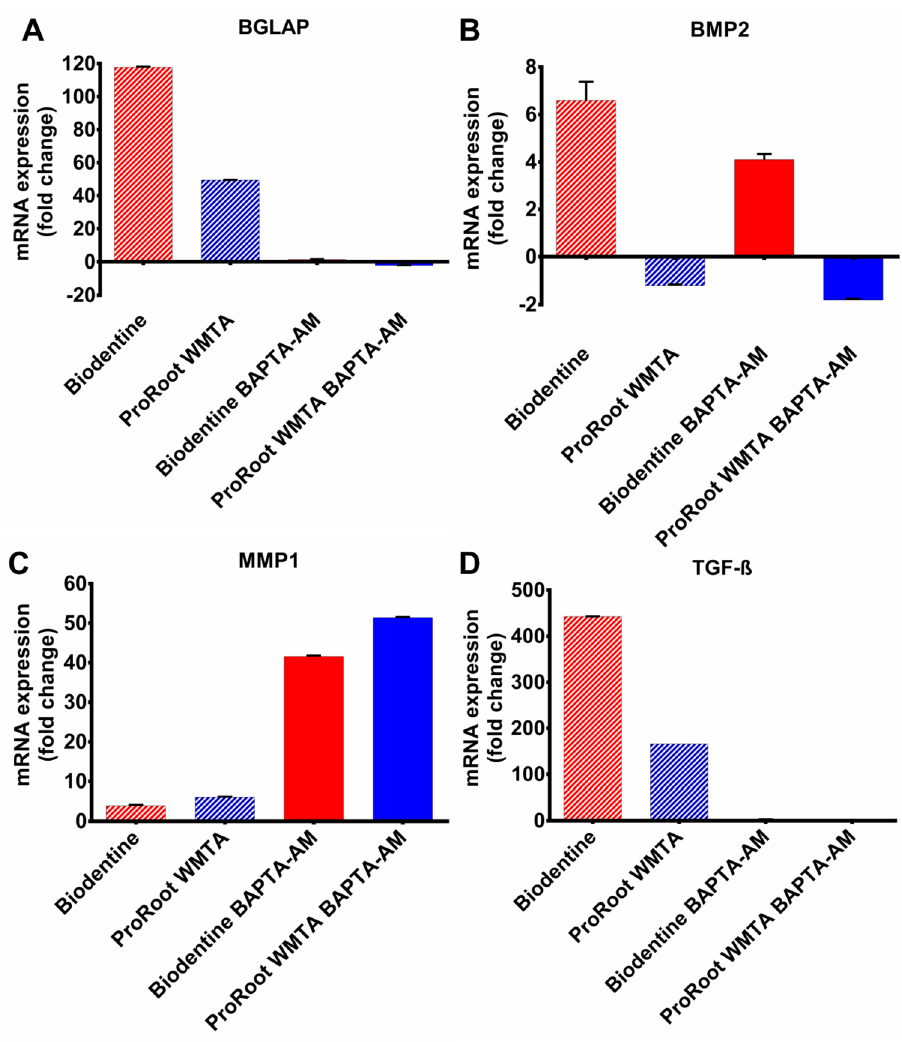
Figure 4. qRT-PCR expression. mRNA expression of ( A ) BGLAP, ( B ) TGF-β, ( C ) MMP1 and ( D ) BMP2 1 day after biomaterial exposure. Histogram shows up-regulated and down-regulated mRNA expression in relative fold change. Details of specific primers used for gene expression analysis are provided in Table